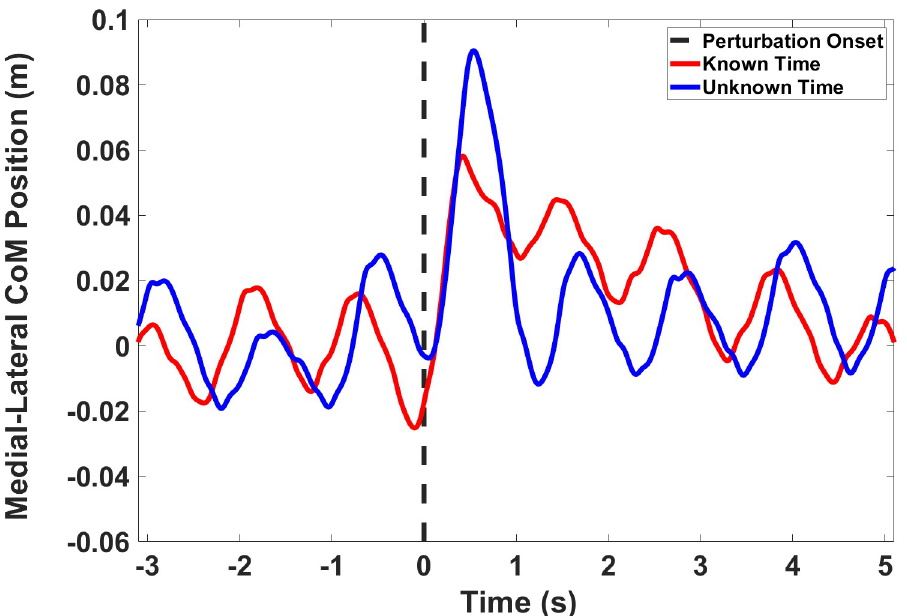
Fig 2. Representative plots of temporal medial-lateral CoM position for a single BKPU subject perturbed toward the impaired limb (positive CoM position values) when the perturbation direction was known and the perturbation timing was either unknown (blue) or known (red). The vertical dotted black line denotes the onset time of the perturbation (time 0) and the y-axis zero denotes the treadmill belt center.